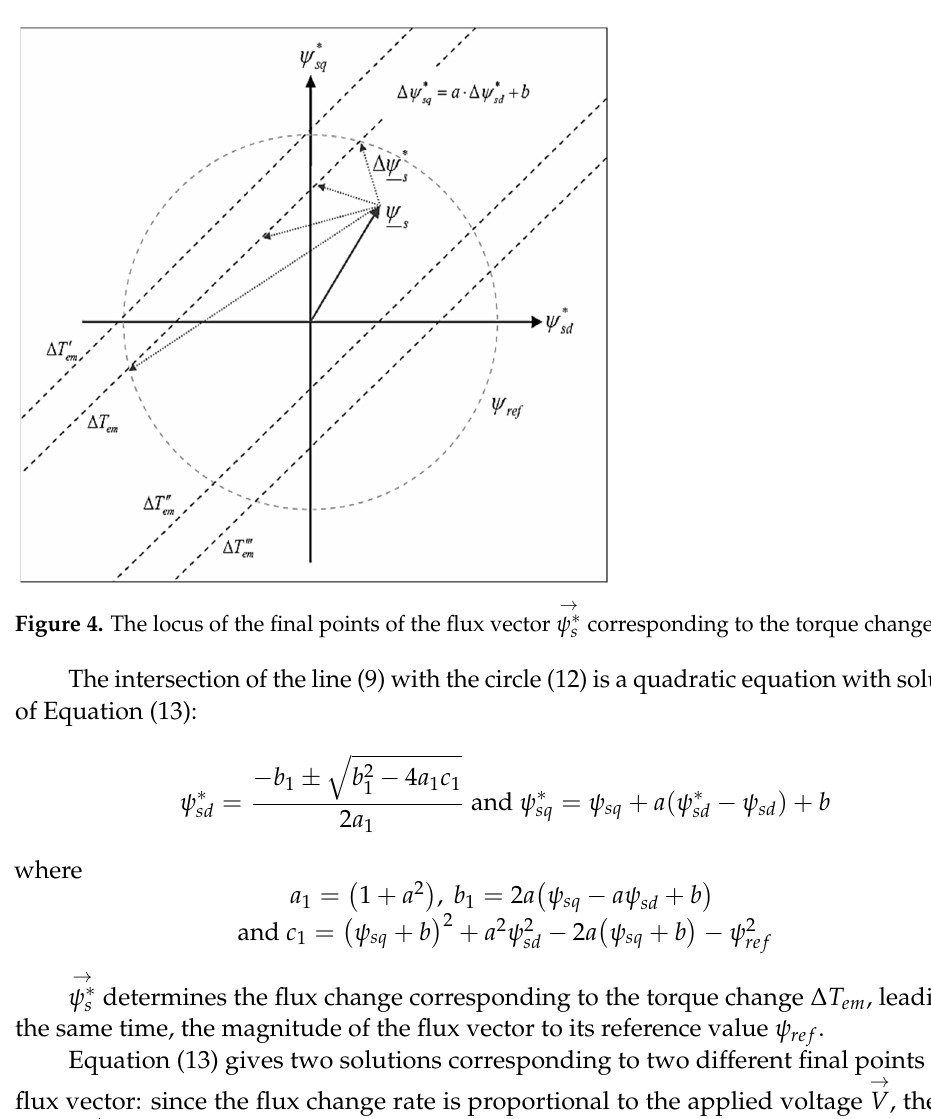
(11) Equation (9) is the locus of the final points of the flux vector 𝜓 (cid:3046)∗ (cid:4652)(cid:4652)(cid:4652)(cid:4652)⃗ corresponding to the torque change ∆𝑇 (cid:3032)(cid:3040) , as depicted in Figure 4. The same figure shows a circumference with the radius ψ ref , which is the reference flux value described by Equation (12): 𝜓 (cid:3046)(cid:3031)∗ (cid:2870) + 𝜓 (cid:3046)(cid:3044)∗ (cid:2870) = 𝜓 (cid:3045)(cid:3032)(cid:3033)(cid:2870) (12) The intersection of the line (9) with the circle (12) is a quadratic equation with solu- tions of Equation (13): 𝜓 (cid:3046)(cid:3031)∗ = −𝑏 (cid:2869) (cid:3399) (cid:3493)𝑏 (cid:2869)(cid:2870) − 4𝑎 (cid:2869) 𝑐 (cid:2869)